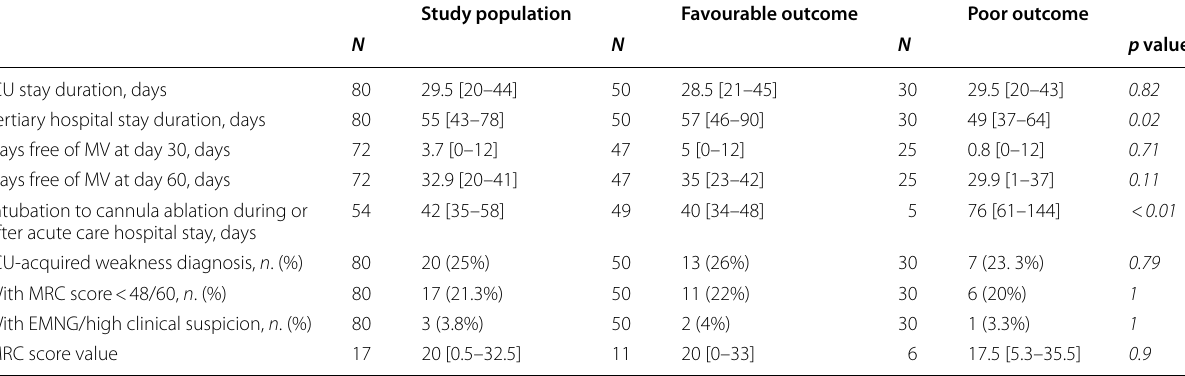
Table 2 General hospital